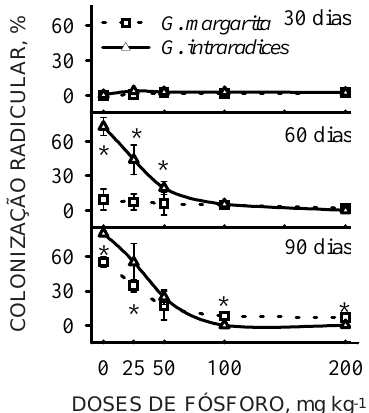
Figura 1. Colonização radicular de soja por fungos micorrízicos arbusculares, considerando as doses de P, aos 30, 60 e 90 dias do transplantio. * Diferenças significativas entre fungos na mesma dose, pelo teste t a 5%. Barras verticais representam o desvio-padrão de três repetições, quando maiores que os